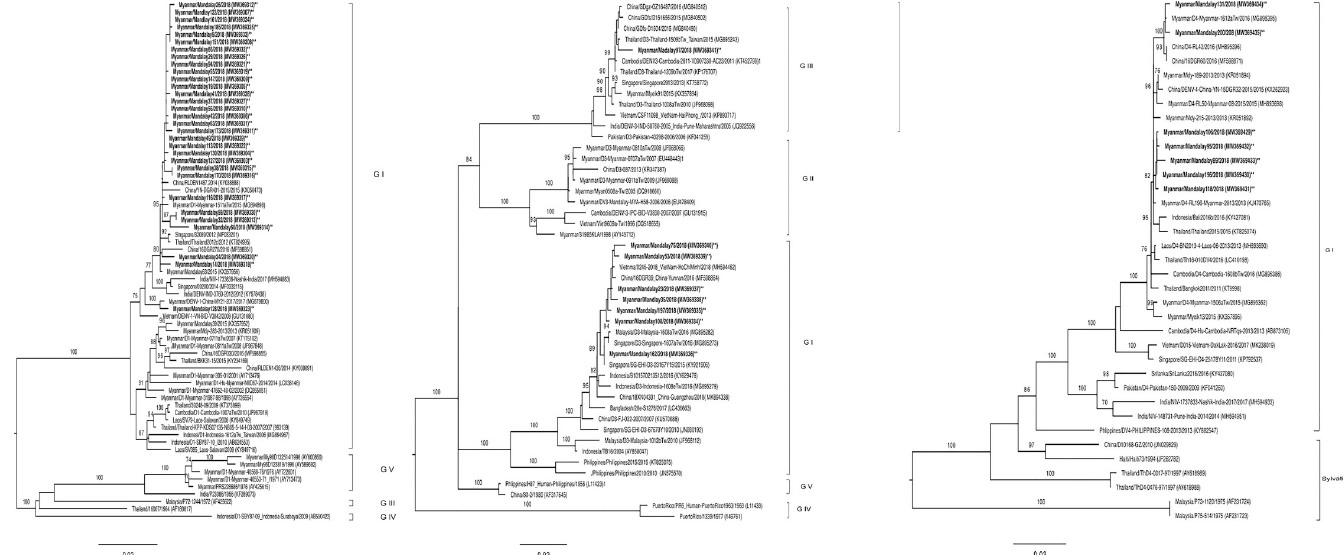
Fig 1. Phylogenetic trees based on the full coding region of the envelope protein gene of (A) DENV-1 (B) DENV-3 and (C) DENV-4. The representative strains of each genotype obtained from Genbank were named by country origin, strain name, year of isolation and GenBank accession number.